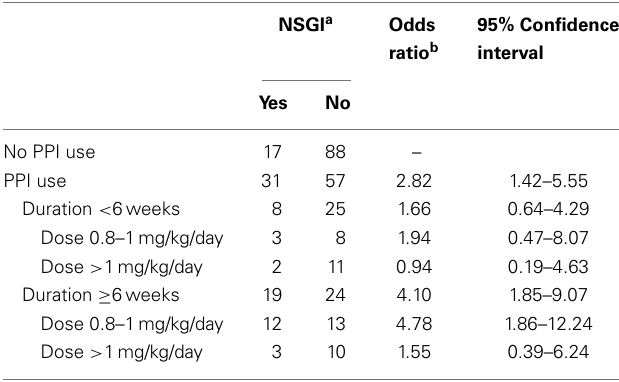
Table 3 | Proton pump inhibitor duration dose category counts and OR (with 95% CI)